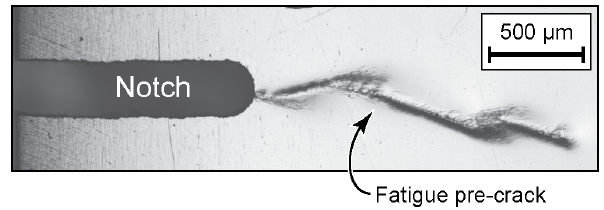
Figure 8. Optical micrograph showing the surface of a specimen after fatigue